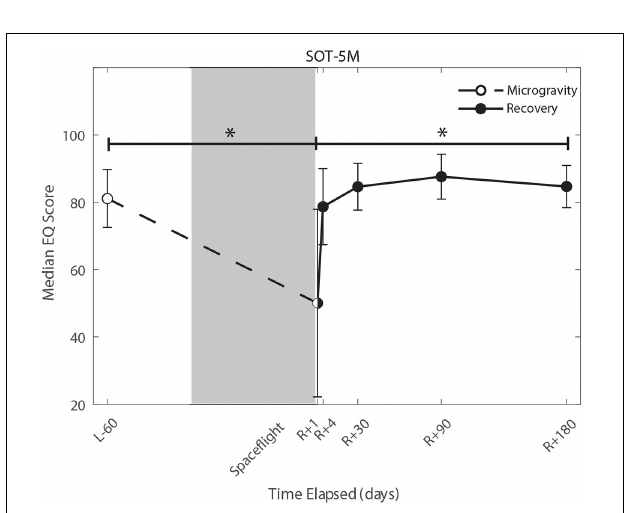
between landing and the first post-flight session was associated with better SWM control task performance.